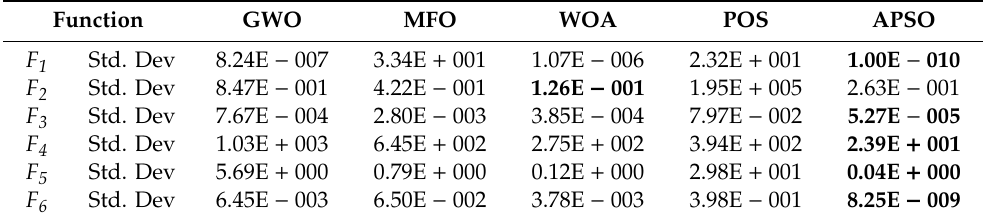
Table 9. The standard deviation (Std. Dev) comparison results of the optimization algorithms. Function